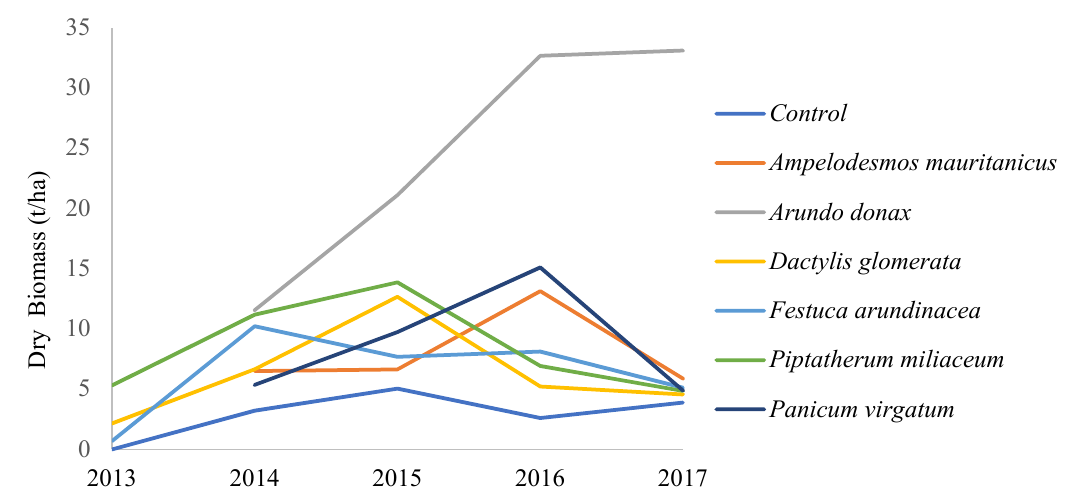
Figure 2. Annual evolution of dry biomass yield in five consecutive growing seasons of the different perennial grasses tested.